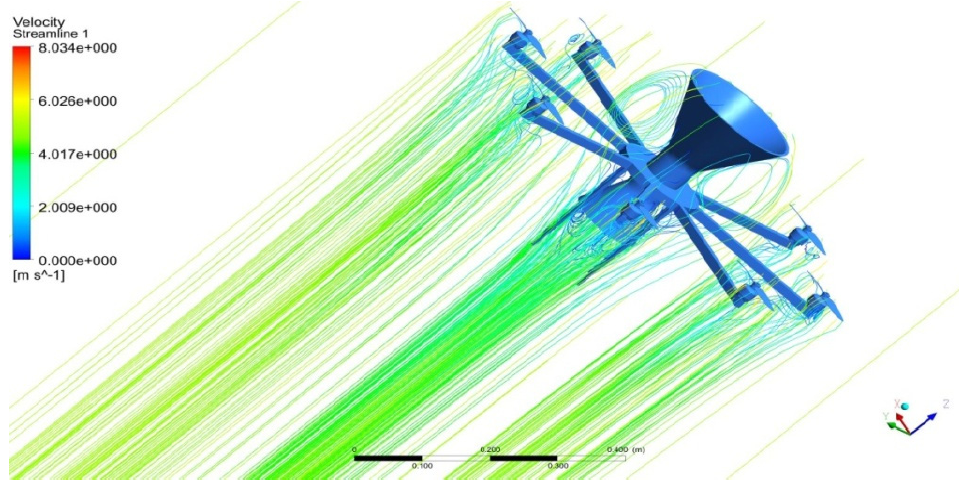
Figure 22. Distribution of velocity over the octocopter (normal atmosphere).